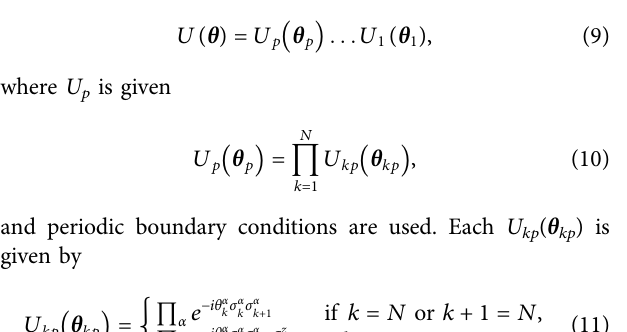
Frontiers in Physics |